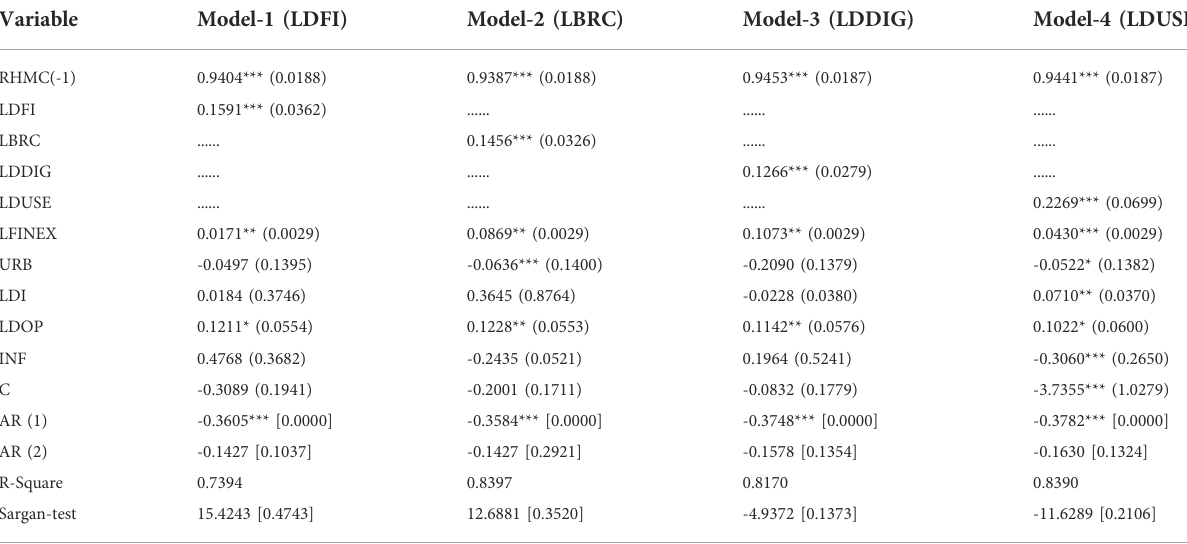
TABLE 5 Results of systematic GMM estimation of the impact of digital inclusion fi nance on rural human capital accumulation.